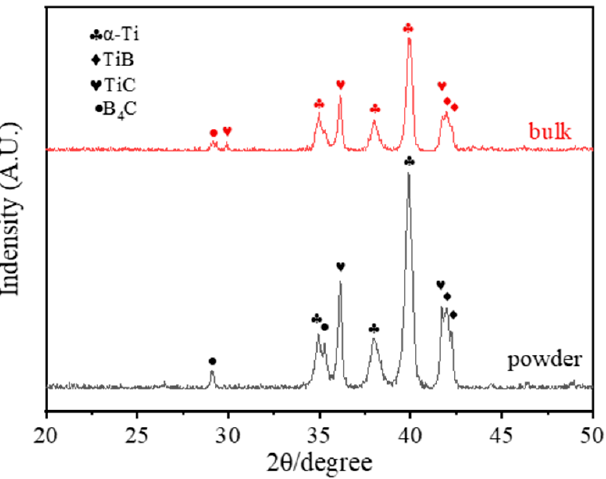
Figure 8. XRD characterization of Ti-B 4 C core-shell structure powder and composite.